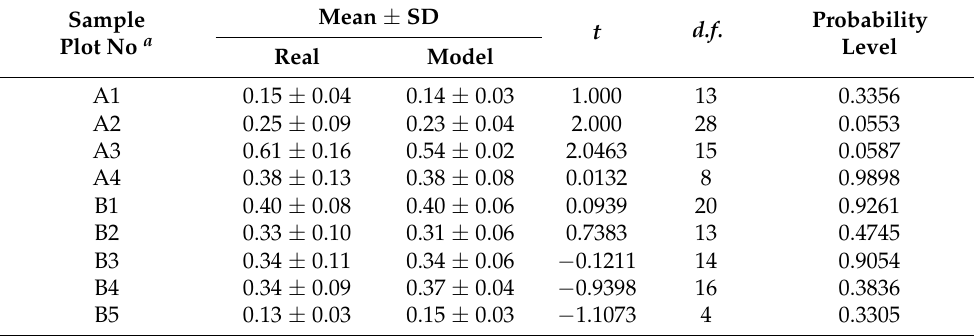
Table 5. Results of comparison of the observed T. piniperda on trap logs: t test, p <